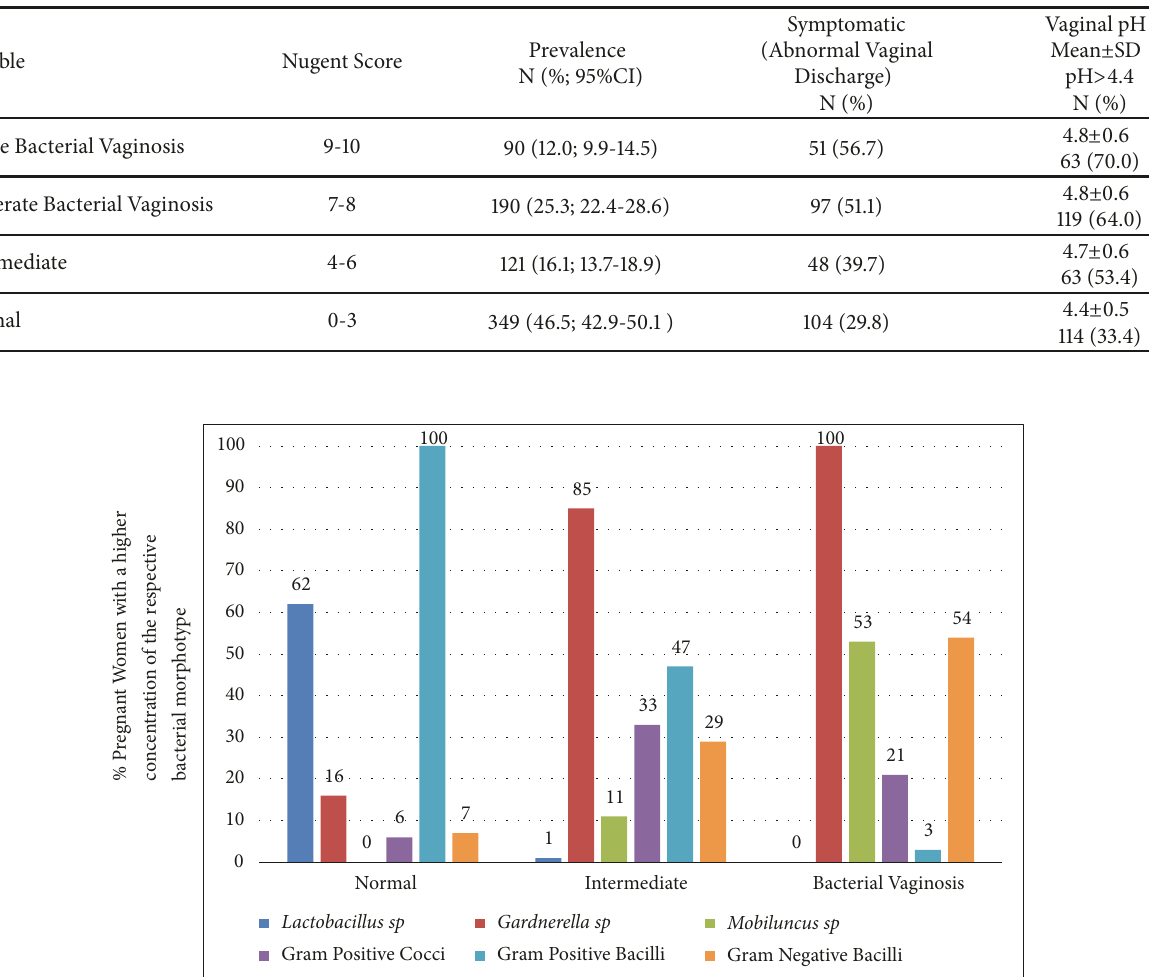
Table 1: Severity of bacterial vaginosis by Nugent score in relation to prevalence, proportion symptomatic, and the mean vaginal pH in HIV uninfected pregnant women.